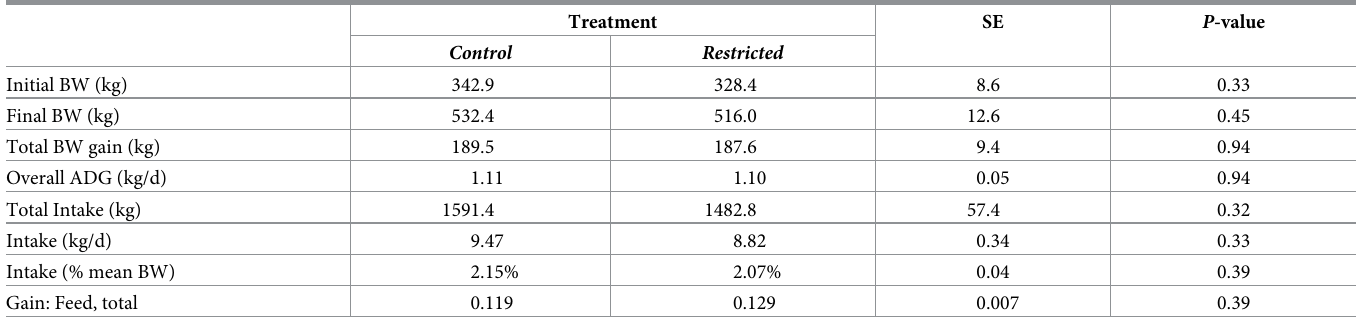
Table 4. Effects of maternal nutritional energy restriction (100% vs 70%) from GD 158 to parturition on feed intake and feed efficiency of Angus cross offspring fed ad libitum from PND 315 to PND 485 (n = 8 per treatment).